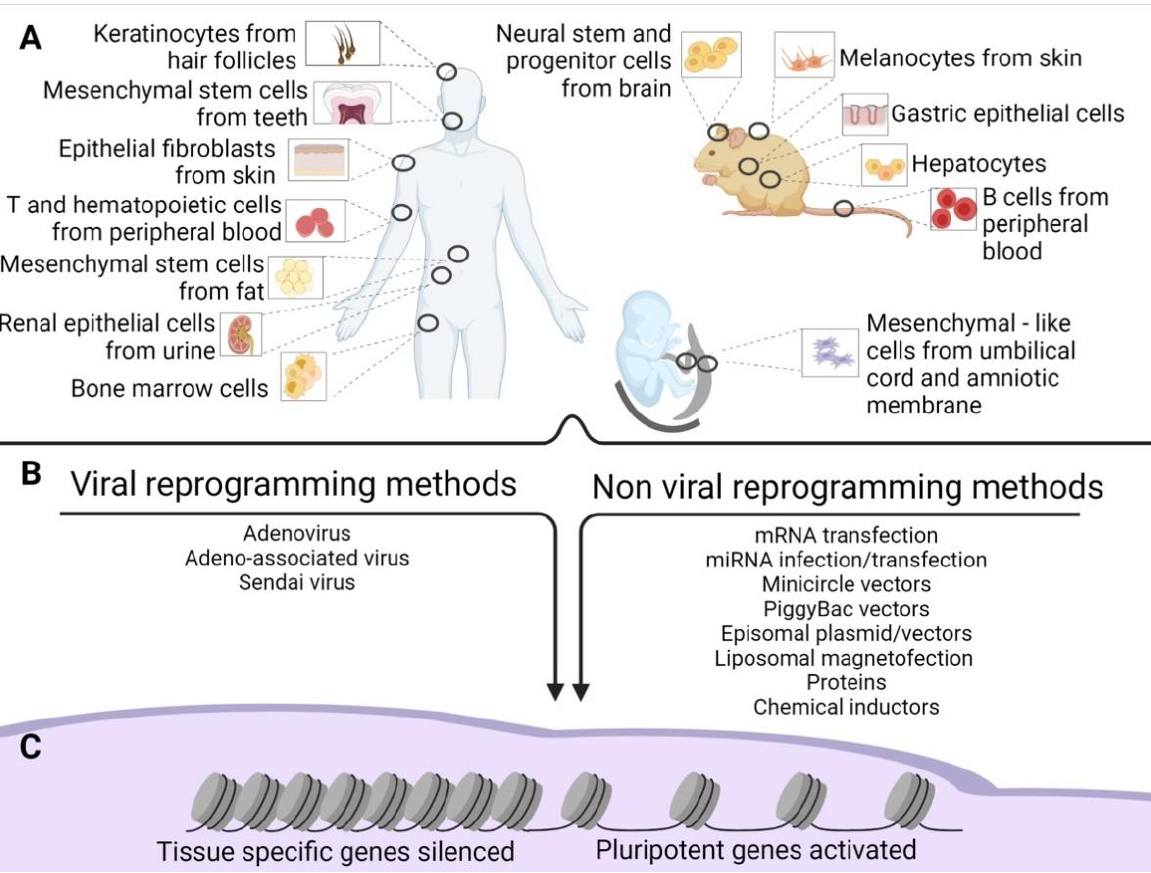
Figure 1. Old and new epigenetic memory in iPSCs. ( A ) Schematic representation of the possible tissue of origin of the source cells used for reprogramming in human and mouse adult tissues and extraembryonic human tissues. ( B ) Methods of reprogramming (viral and non-viral) of the source cells. ( C ) Gene silencing and activation after reprogramming.